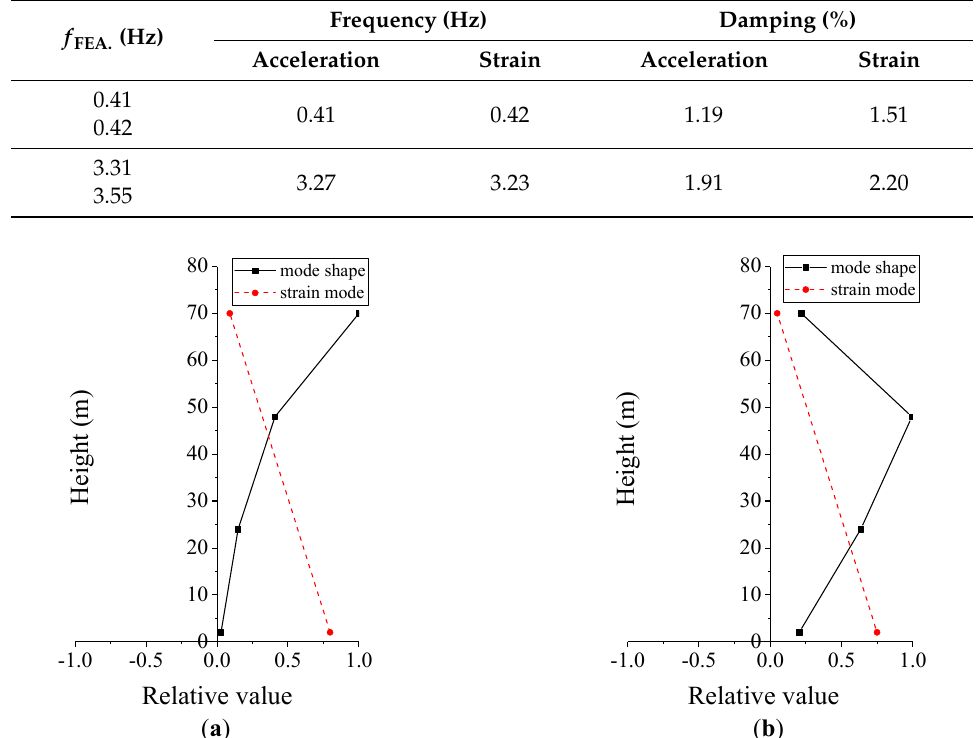
Figure 10. Mode shape identified by accelerometers y2, y4, y6, and y8 and the strain mode by strain sensors S8 and S10: ( a ) 1st mode; ( b ) 2nd mode. Table 4. Averaged values of the modal parameters identified by both the strain sensors and accelerometers.